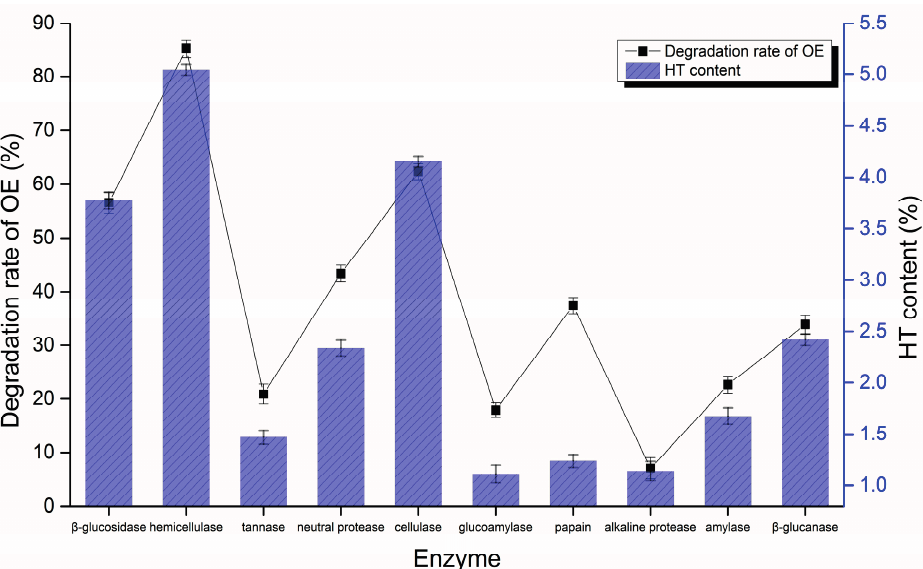
Figure 2. Enzymatic effect of different enzymes ( n =